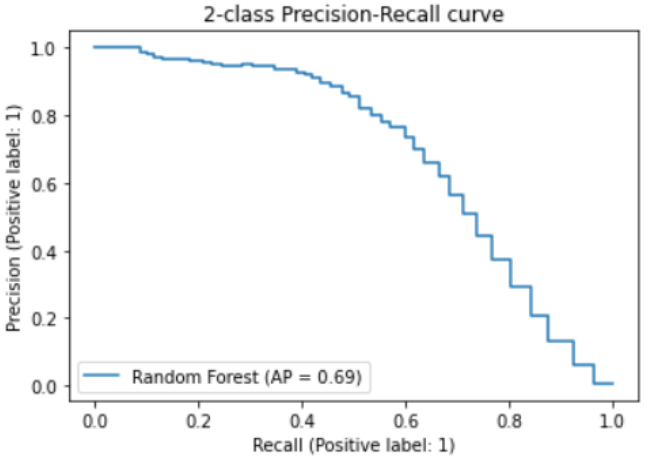
Figure A15. Extracted feature samples using the VGG16 model.